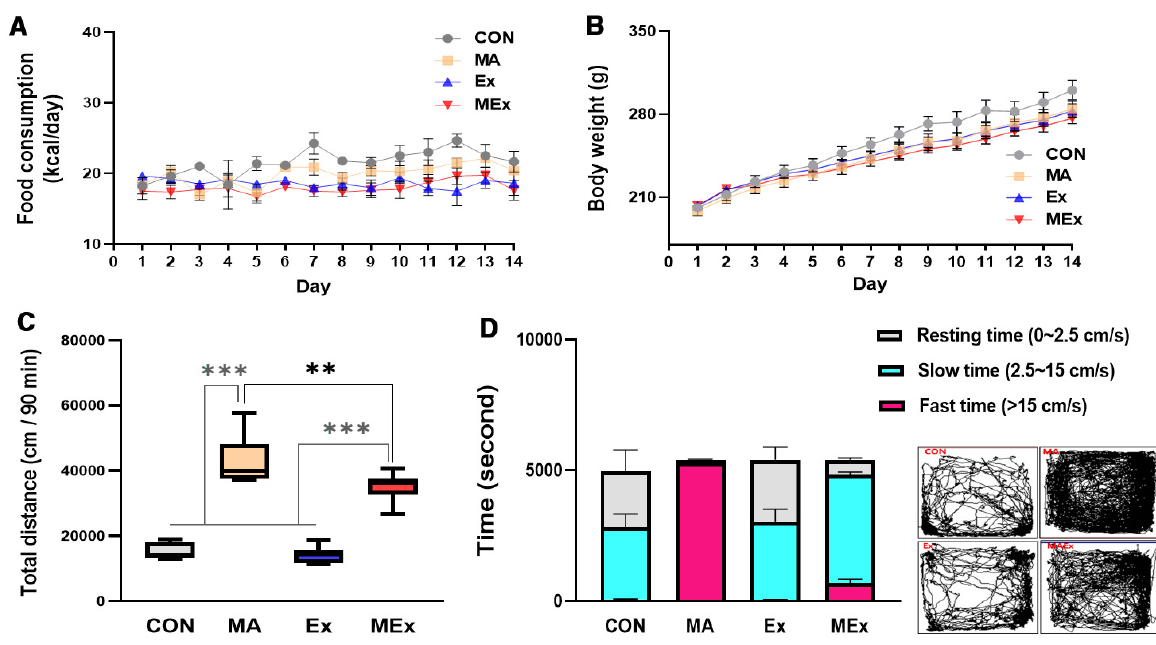
Figure 2. Forced moderate endurance exercise significantly reduced methamphetamine (METH)-induced hyperactivity. ( A ) Changes in food consumption ( n = 8 per group, F (39, 261) = 1.275). ( B ) Changes in body weight ( n = 8 per group, F (39, 248) = 1.744). ( C ) Total distance covered by the animal during the locomotor test conducted for 90 min ( n = 7 per group, F ( 3, 24 ) = 67.96). ( D ) The classification ratio according to the movement speed within the total travel time ( n = 7 per group). Values are means ± SE, *** p < 0.001, ** p < 0.01. CON, saline control; METH, methamphetamine; MA, METH administration; Ex, saline + exercise; MEx, METH + exercise.